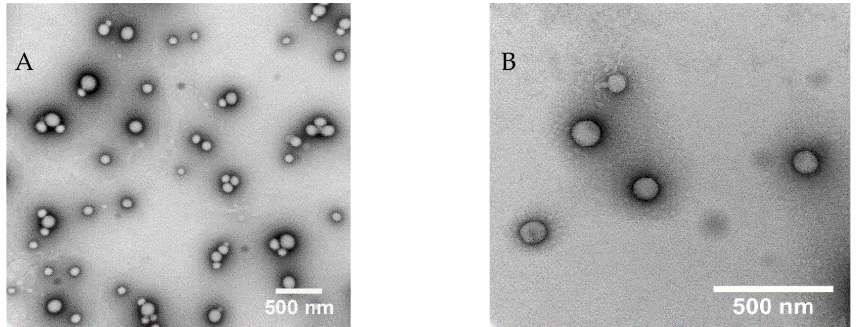
Figure 2. TEM image of ATRA-PLGA NPs corresponding to 0.1 mg/mL of PLGA. Image acquisition using a Hitachi H7650 TEM (Hitachi, Chiyoda, Tokyo, Japan) operating at 100 kV with a side mounted camera at a magnification of ( A ) 40,000× and ( B ) 100,000×. Scale bar: 500 nm.